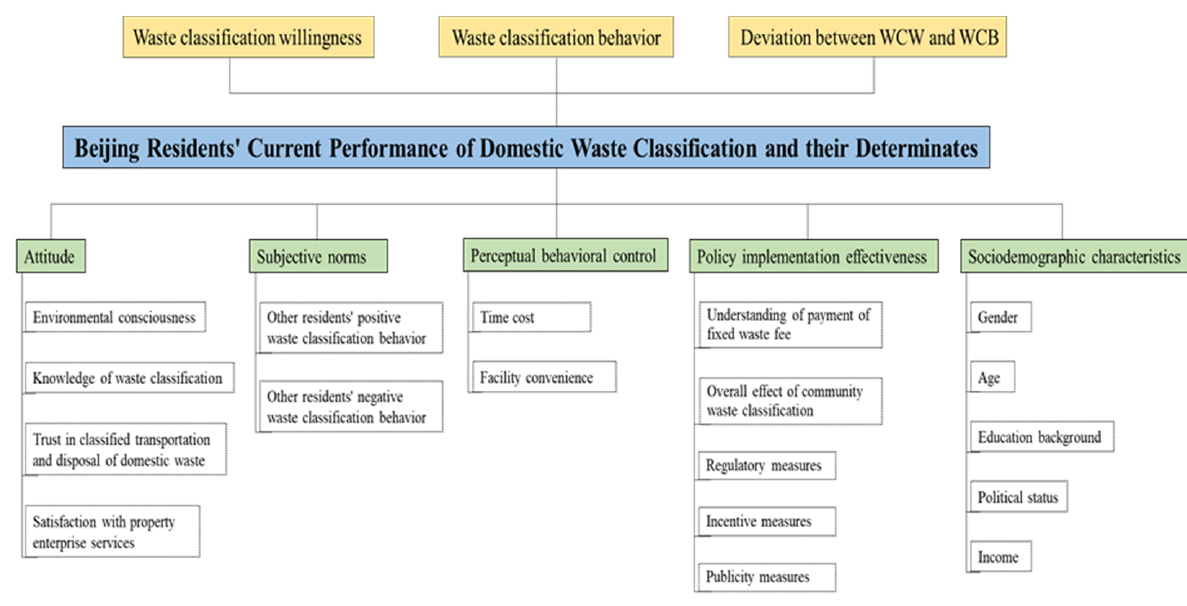
Figure 2. Research framework of residents’ WCW, WCB and their deviation.